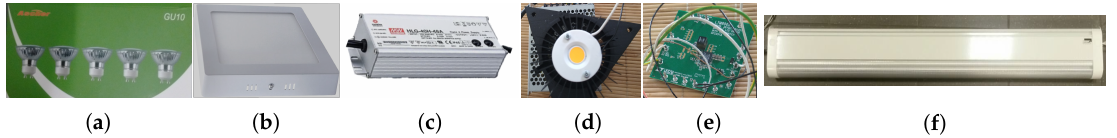
Figure 1. Illustration of the LED fixtures and drivers considered: ( a ) KLLUG-511, ( b ) 18WLEDQSM, ( c ) HLG-40H-48A, ( d ) BXRE-35E2000-C-73, ( e ) LTM8005 Demo Board and ( f ) E4010/LED1N060D.